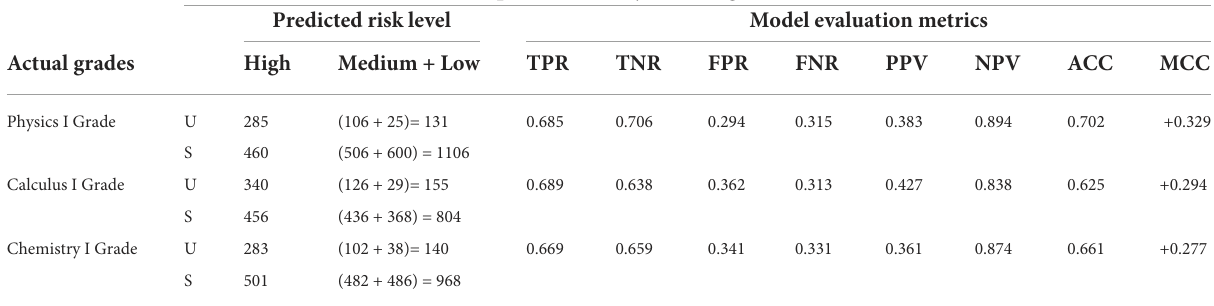
TABLE 1 Confusion matrices with student-counts demonstrating early STEM foundation course performance measured as Satisfactory (S)/Unsatisfactory (U) grade, by predicted risk categories for Fall 2006–2010 cohorts for the Math Diagnostic cut-off of 0.65 and Physics Diagnostic cut-off of 0.5.